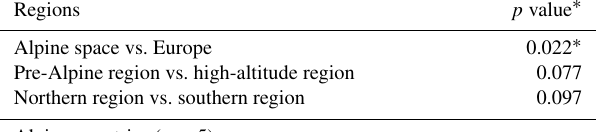
Table 1. Results of the pairwise Wilcoxon rank sum test compar- ing the central tendencies between different regions, i.e. the paired domains and smaller subregions. For subregions, results are shown only for combinations differing by a p value ≤ 0.15. Regions p value ∗ Alpine space vs. Europe 0.022 ∗ Pre-Alpine region vs. high-altitude